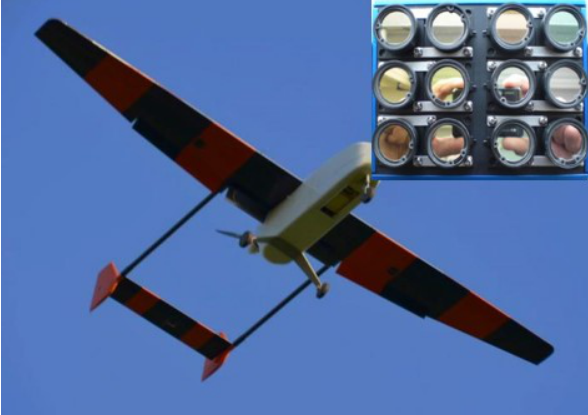
Figure 2. Unmanned aerial system (UAS) Carolo P360 with multi- camera array Mini-MCA 12 (visible lenses at the underside of the